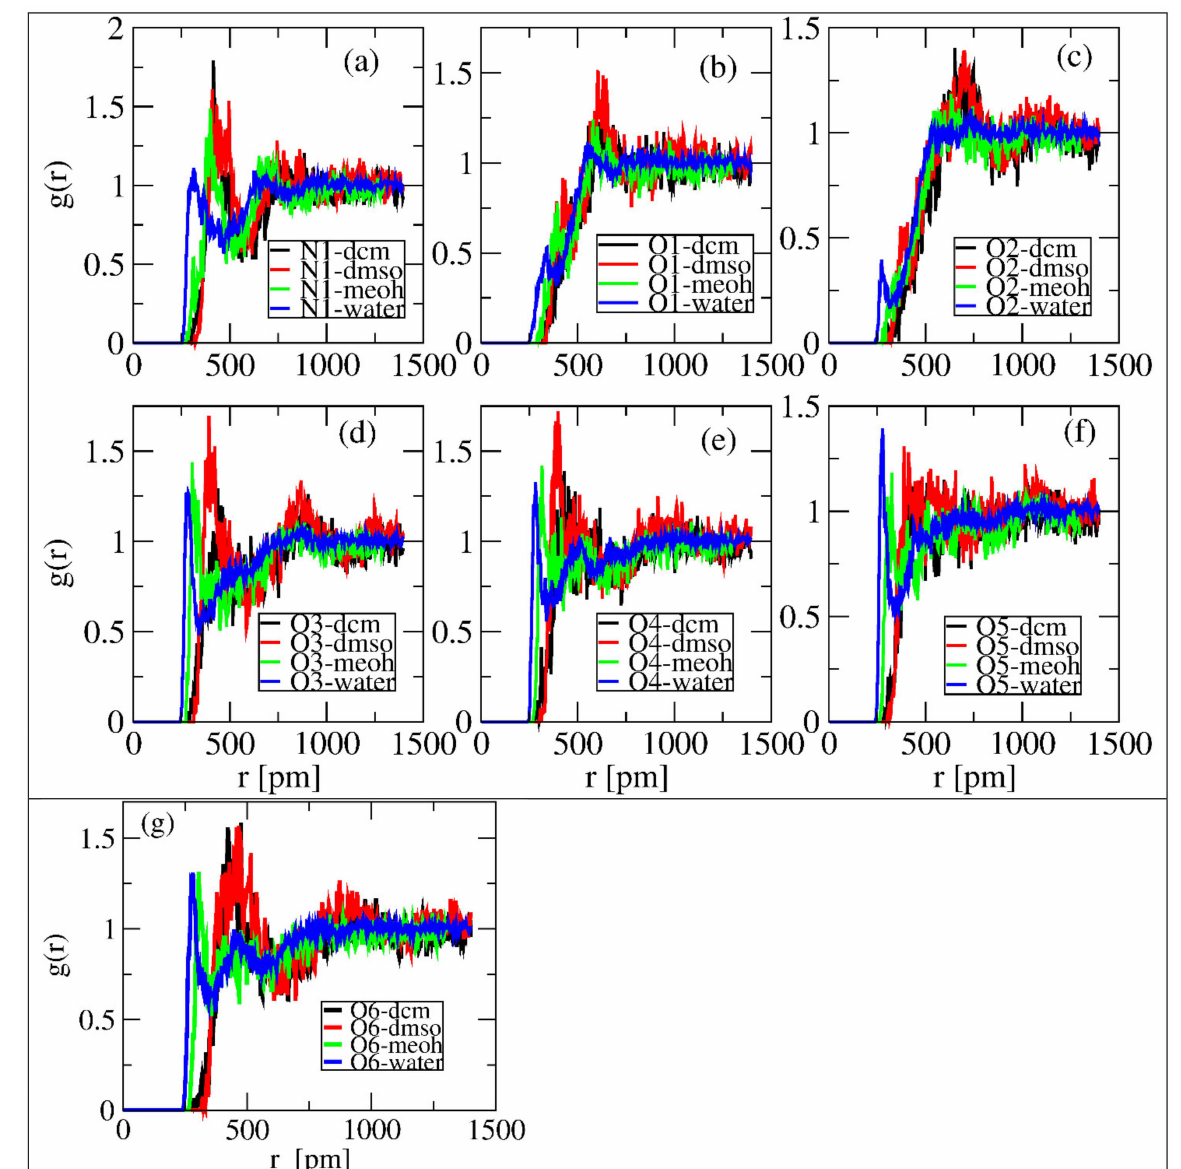
Figure 5. RDF of polar atoms around linamarin and centres of mass of solvents correspond to ( a ) N1, ( b ) O1, ( c ) O2, ( d ) O3, ( e ) O4, ( f ) O5 and ( g ) O6 of linamarin, as a reference